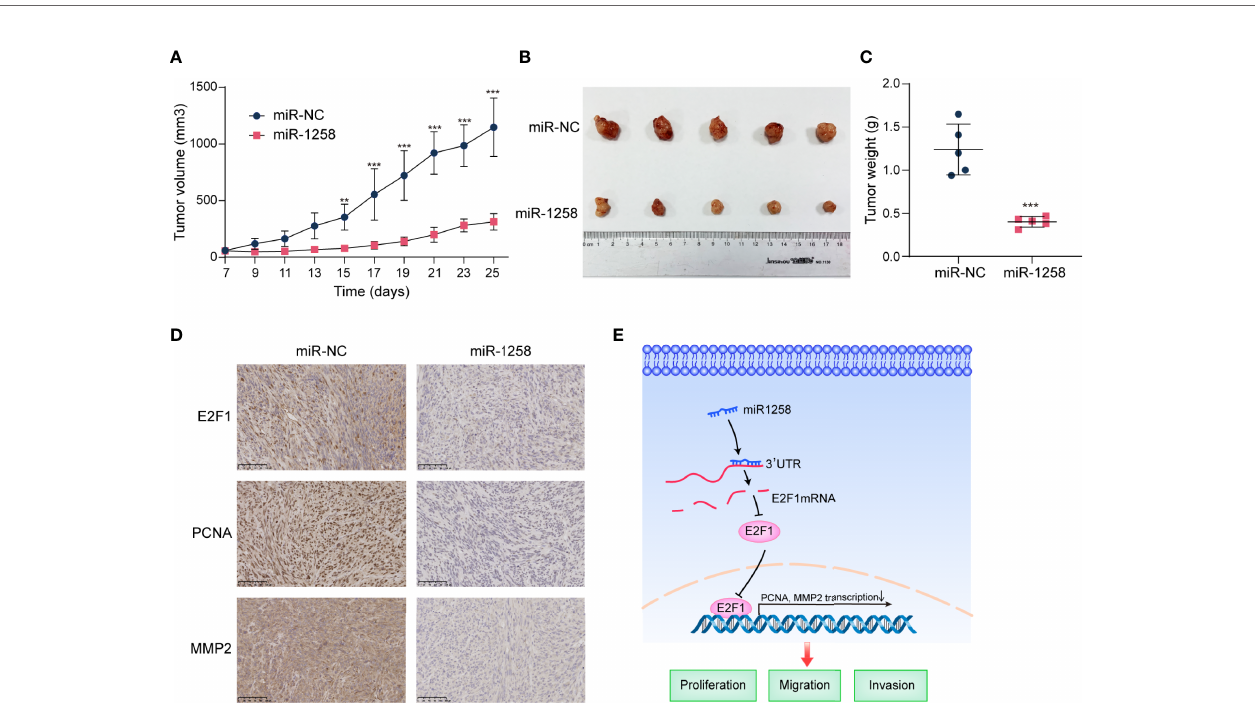
FIGURE 6 | miR-1258 decreases tumorigenicity and invasion characteristics in xenograft model. (A) Stable ‐ transfected U251 cells with miR-1258 mimic or miR-NC were implanted bilaterally in the axillary, respectively, per mouse. The volumes of subcutaneous xenografts were measured from day 7 to day 25 every 2 days (V=0.5×width2×length, units: mm3, n=5); **p < 0.01, ***p < 0.001 at indicated time points, when compared to miR-NC group. (B) Respective images of subcutaneous xenografts were shown. (C) The tumor weights were decreased in miR-1258 group; ***p < 0.001 between indicated groups. (D) The expressions of E2F1, PCNA, and MMP2 signi fi cantly diminished in miR-1258 group detected by immunohistochemical analysis. Representative images were shown; Scale bar, 100 m m. (E) The mechanistic scheme illustrated that miR-1258 attenuates tumorigenesis through targeting E2F1 to inhibit PCNA and MMP2 transcription in